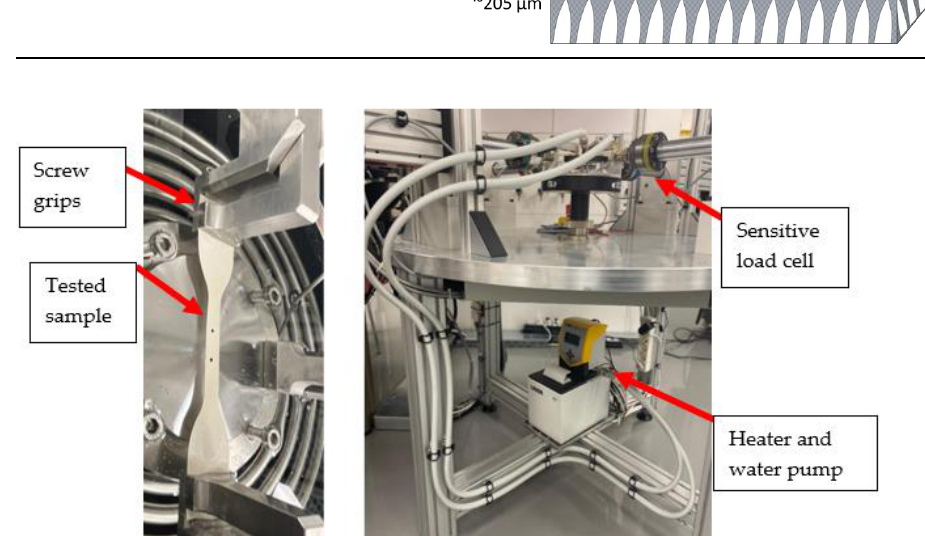
Figure 4. Bath heater and thermoregulation